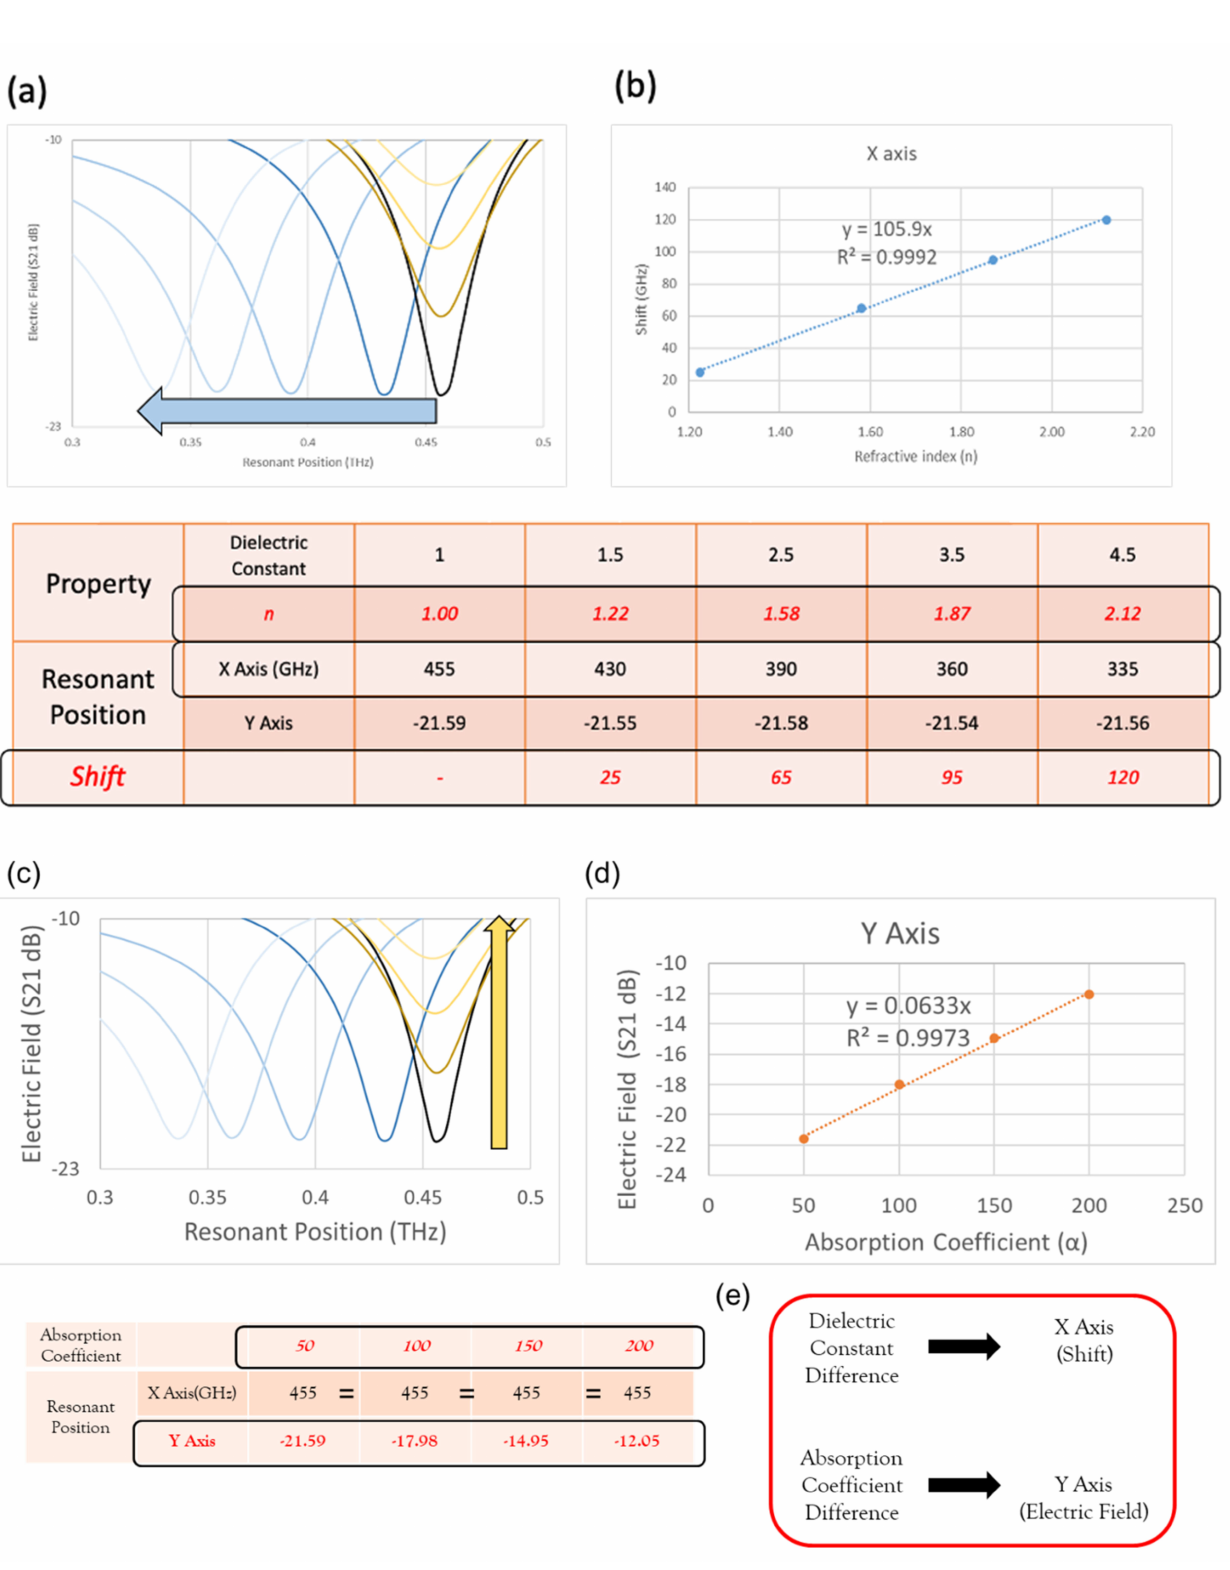
Figure 7. ( a ) Resonance curves of analytes with dielectric constants of 1, 1.5, 2.5, 3.5, and 4.5. ( b ) The relationship between the refractive index and shifts. ( c ) Resonance curves of analytes with absorption coefficients of 50, 100, 150, and 200. ( d ) The relationship between absorption coefficients and the electric field. ( e ) The influence of the dielectric constant and absorption coefficient on the position of the X- and